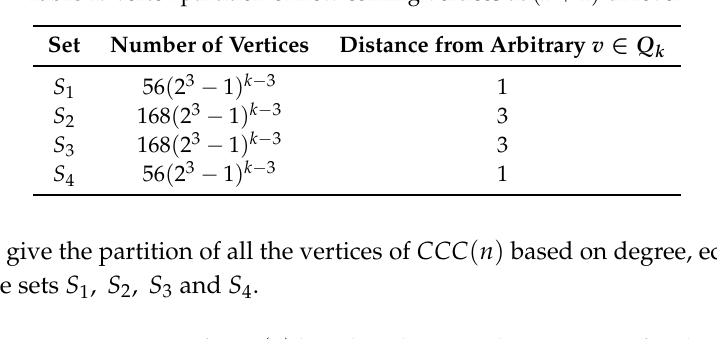
Table 2. Vertex partition of CCC ( n ) based on degree and eccentricity of each